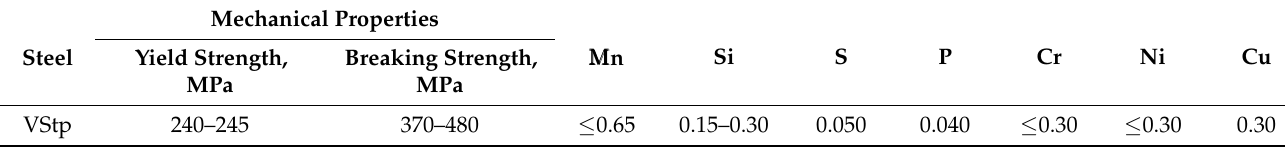
Table 1. Mechanical characteristics of the model’s body